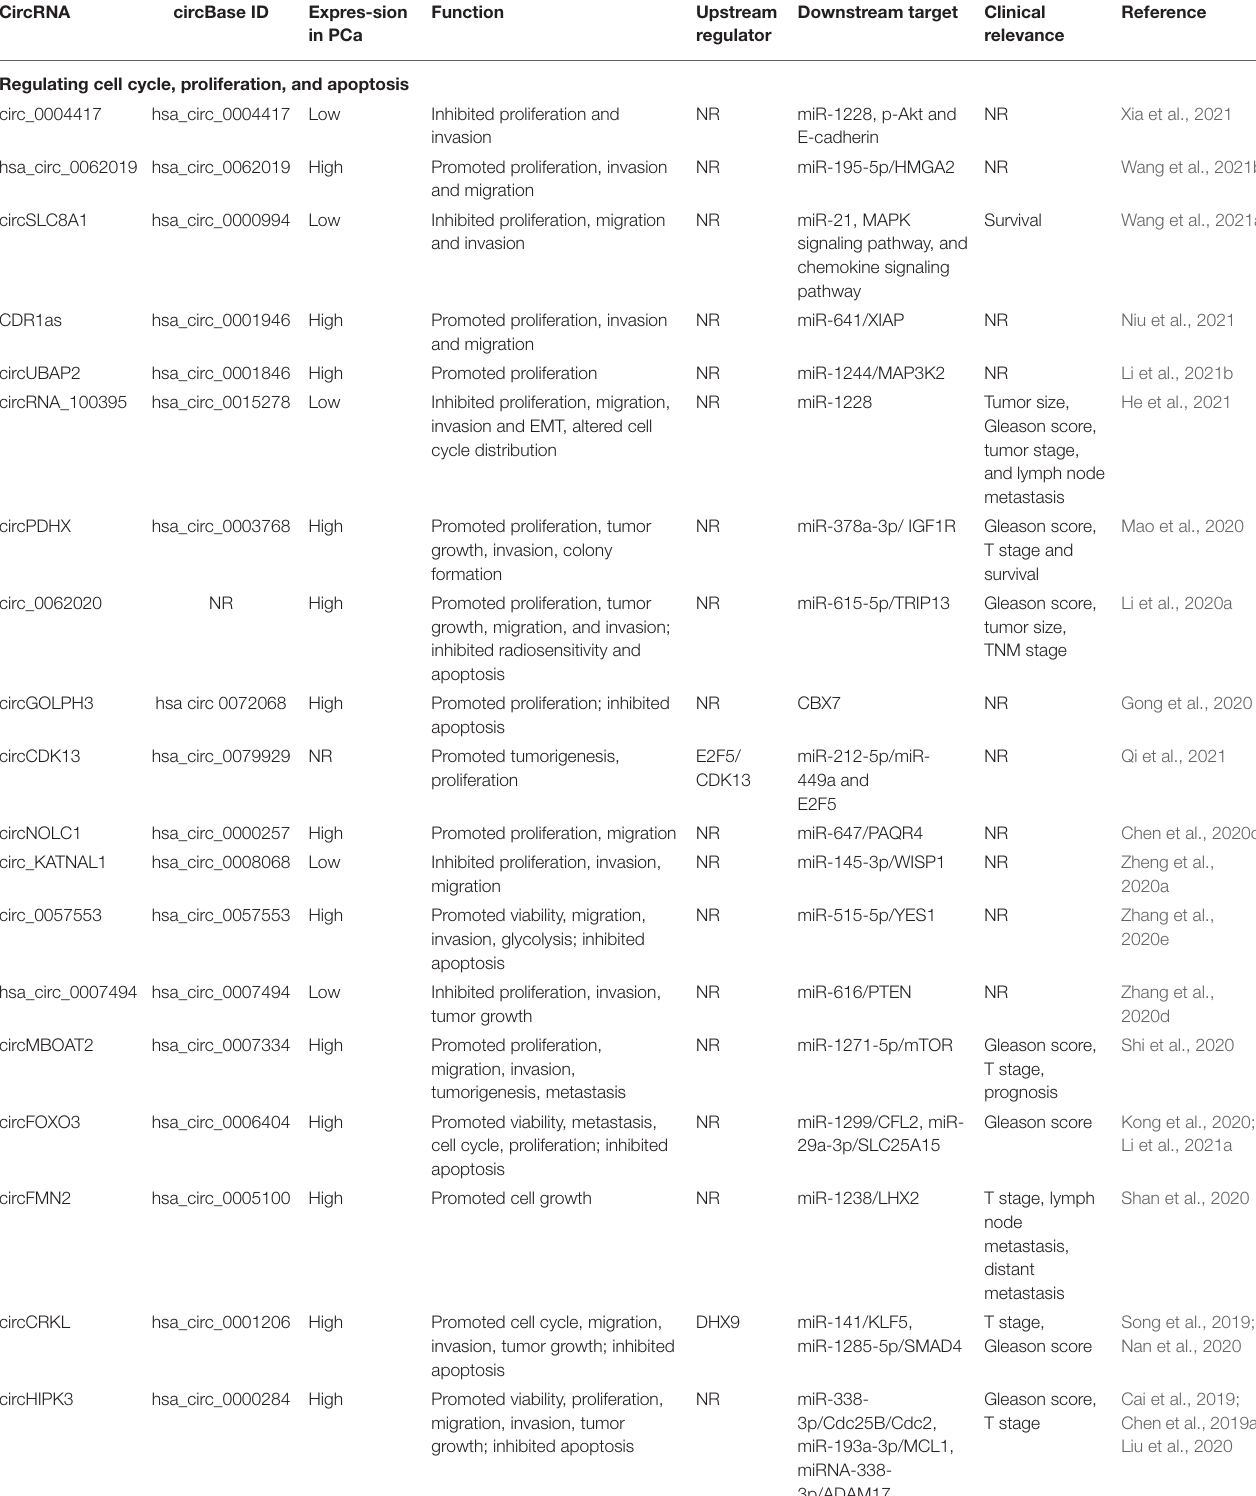
TABLE 1 | Overview of functional circRNAs in prostate